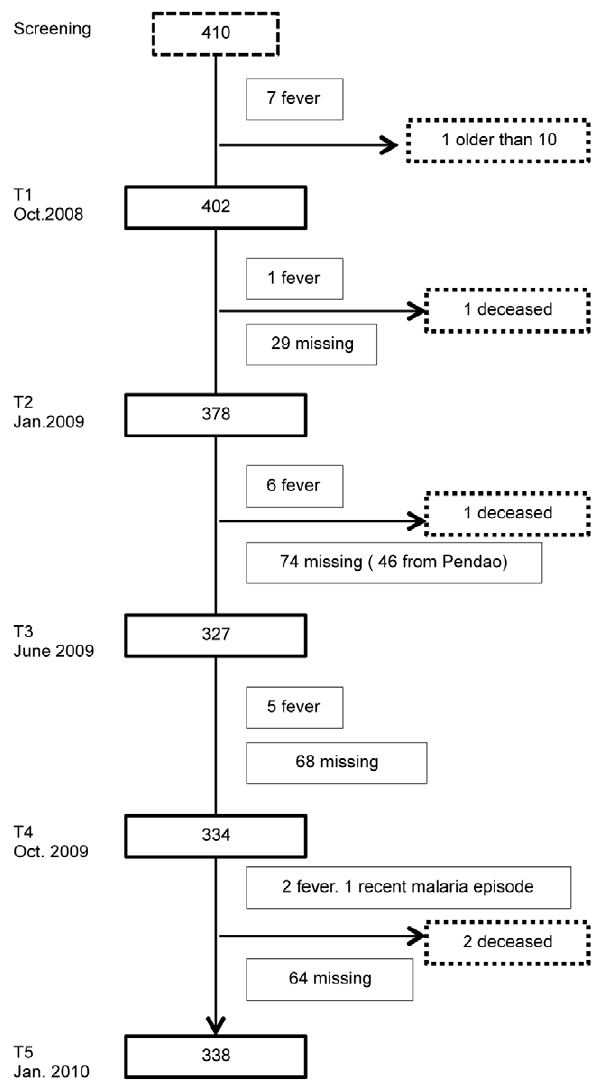
Figure 1. Flow of participants through the study.